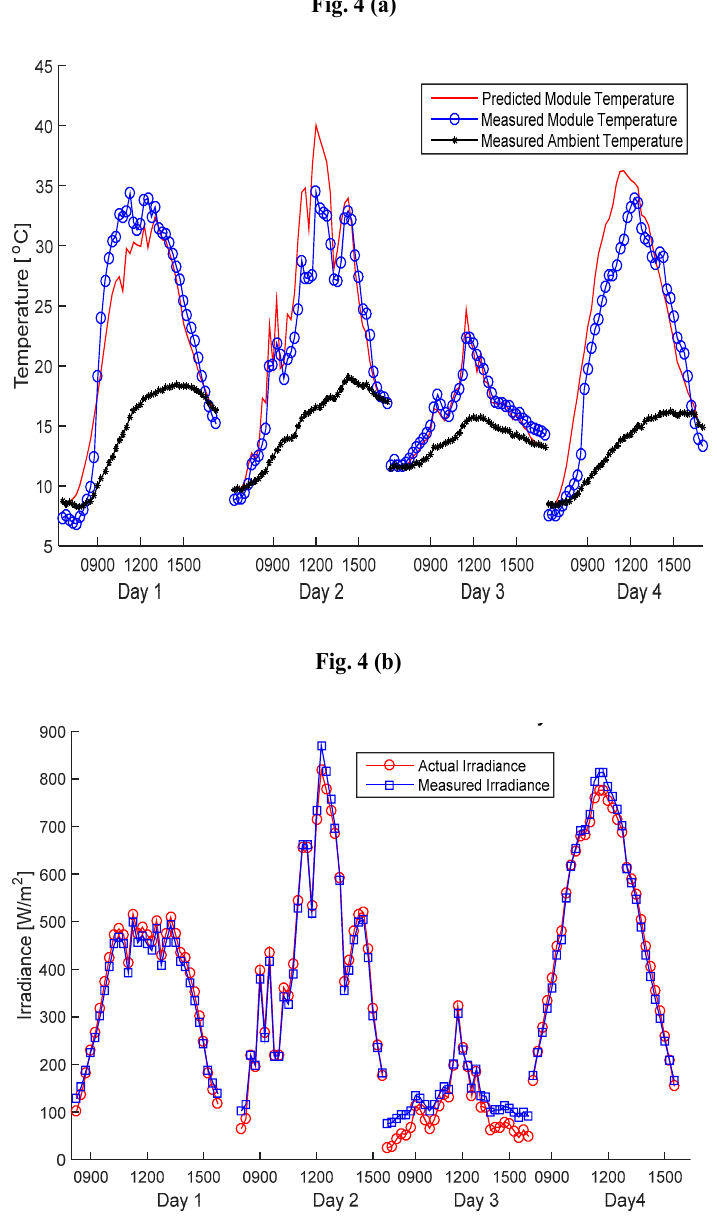
Figure 4. Comparison between measured and predicted values for four days for installation at Lahore, Pakistan. ( a ) Temperature comparison, ( b ) Irradiance comparison.